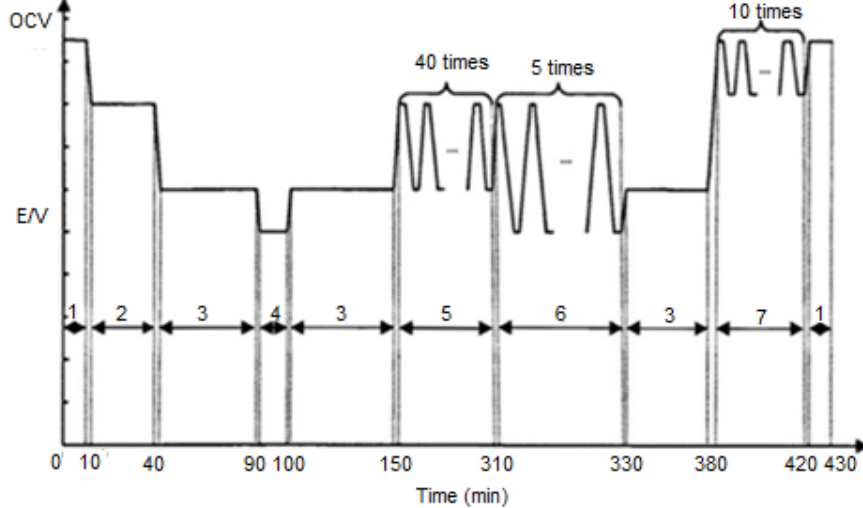
Figure 11. Wuhan University of Technology test protocol [4] (Reproduced with permission from Huicui et al. [4], Applied Energy; published by Elsevier Ltd., 2018).